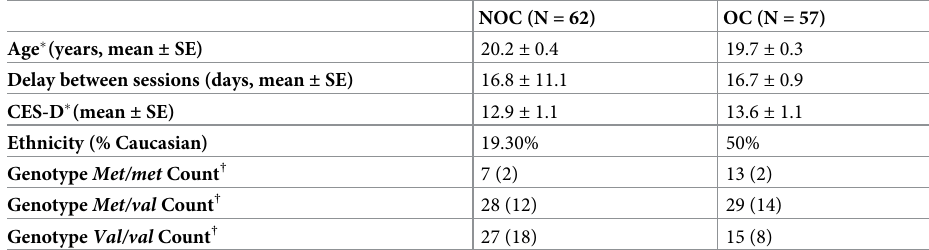
Table 1. Demographics and COMT distribution of NOC and OC.